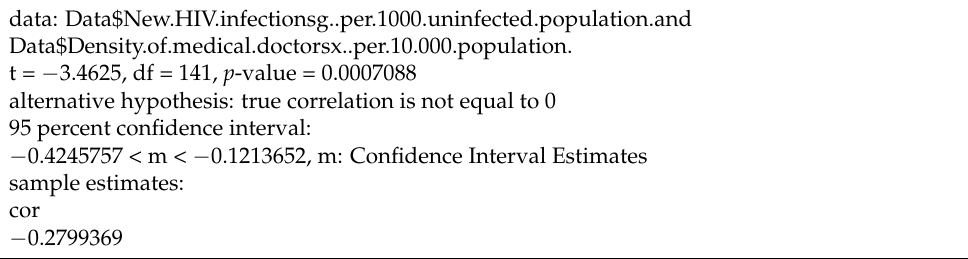
Table 12. STDs (HIV infection) infection rate according to medical doctor density. data: Data$New.HIV.infectionsg..per.1000.uninfected.population.and